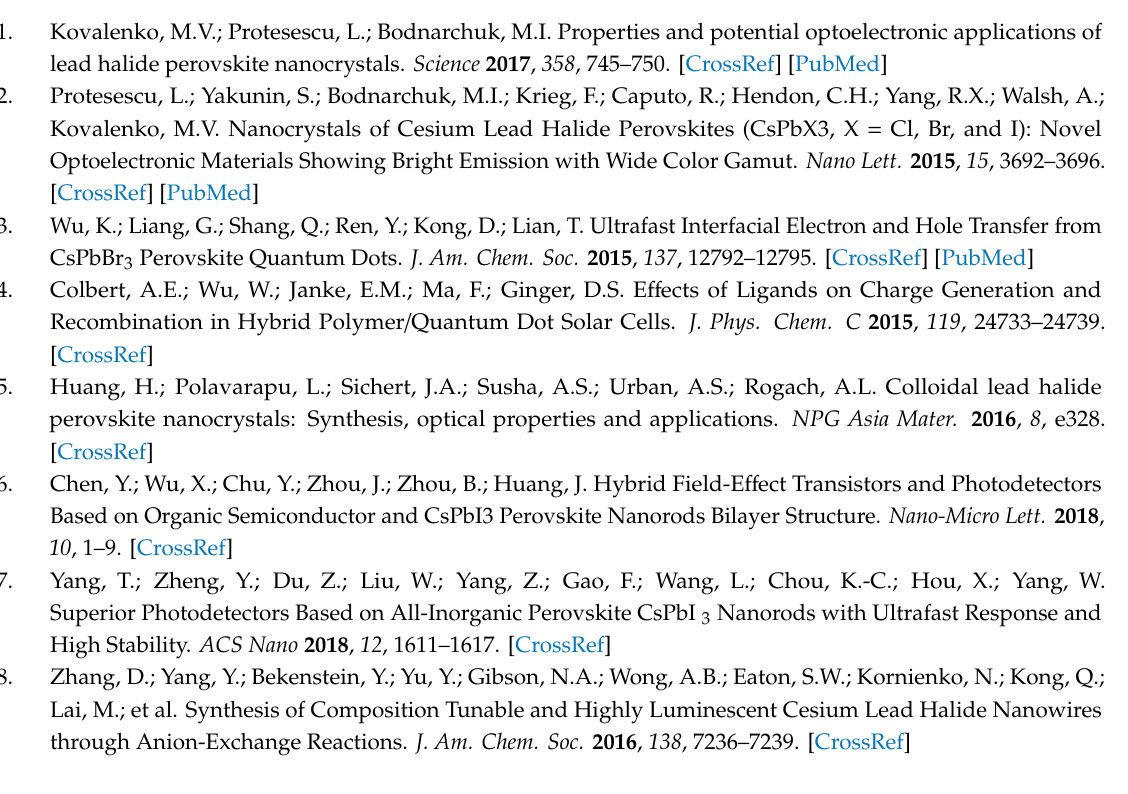
Table S1. Comparison of perovskite-based photodetectors. Figure S1. PL (red curve) and absorbance (blue curve) of colloidal PbS QDs used in this work for preparation of films in tandem devices with films of CsPbBr 3 PNCs. Figure S2. FTIR spectra measured (with the ATR Agilent Cary 630 setup) in a film of a pristine film of OA-OAm-capped CsPbBr 3 PNCs (red continuous line) and the same film after MPA ligand exchange procedure (blue continuous line). Figure S3. Schematic energy level diagram of a complete photovoltaic device based on the light absorbing layer of CsPbBr 3